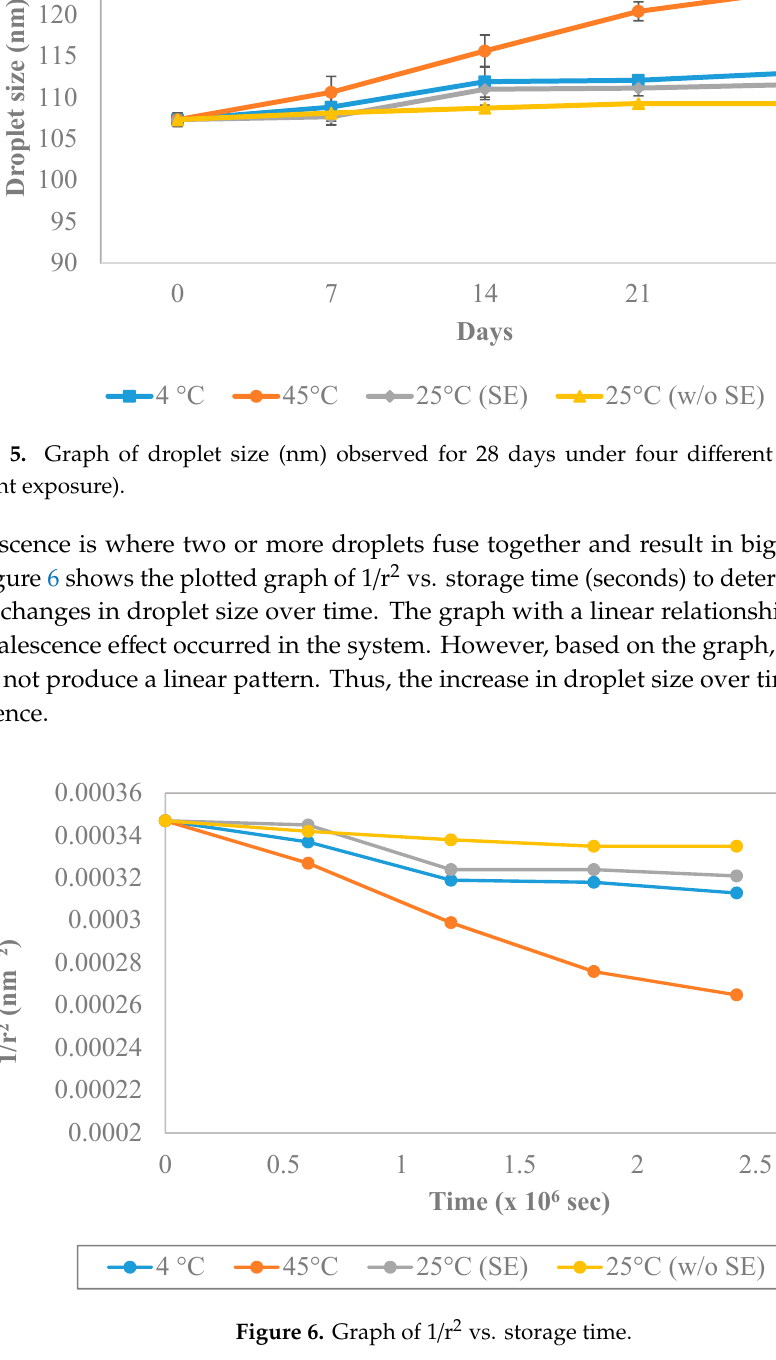
Figure 7. Graph of r 3 vs. storage time (seconds). 4. Conclusions In this study, a nanoemulsion formulation containing KMO in a thin film system was successfully developed. The droplet size of the KMO formulation was optimized using the RSM approach and characterized for its thin film system and physicochemical properties. The optimized KMO nanoemulsion formulation with desirable criteria was PVA (27.61% w/w), PG (1.05% w/w), and shear rate (8656.17 rpm) with predicted droplet size (110.21 nm) and actual droplet size (105.93 nm) with a residual standard error (% RSE) < 2.0% was obtained. Analysis of variance showed that the fitness of the quadratic polynomial fit the experimental data with F-value (65.30), a low p -value (P < 0.0001), and a non-significant lack-of-fit. The optimized KMO formulation showed the desired criteria of a thin film system with flexible and peelable characteristics, is non-sticky, and has a short drying time of 7 min 25 s, which shows its suitability for topical application as a peeling mask. The physicochemical properties (Zeta potential − 37.37 mV, PDI 0.13, pH 4.74) and the stability of the KMO formulation under centrifugal force, and a stability study for 28 days at four different conditions of 4